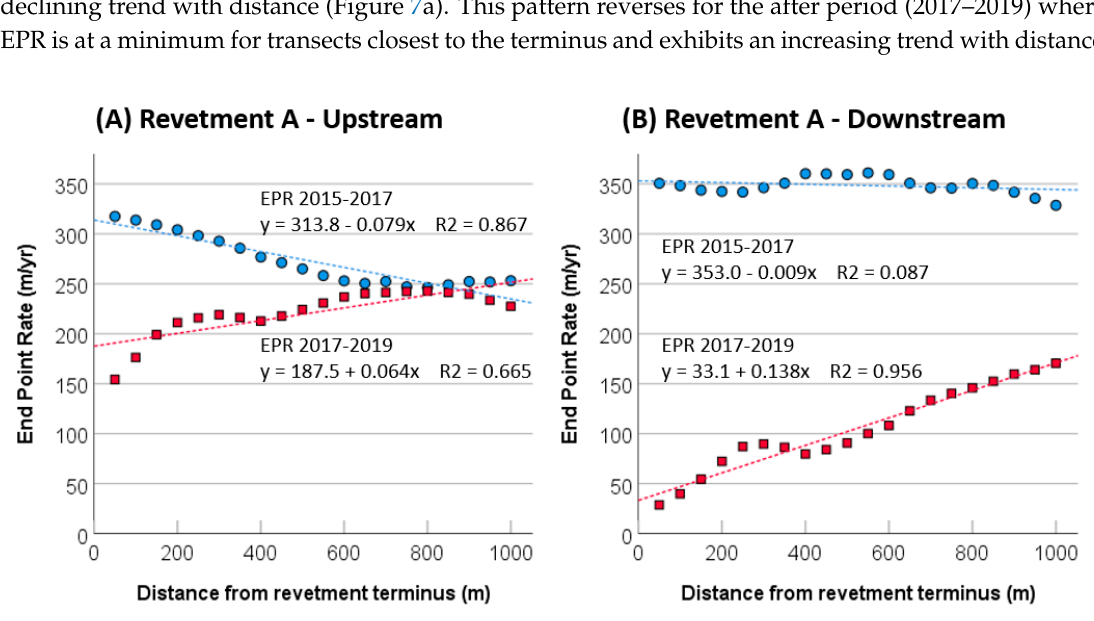
Figure 7. Revetment A End Point Rate: ( A ) upstream, ( B ) downstream; circles = EPR for 2015–2017, squares = EPR for 2017–2019; linear regression trend lines shown.